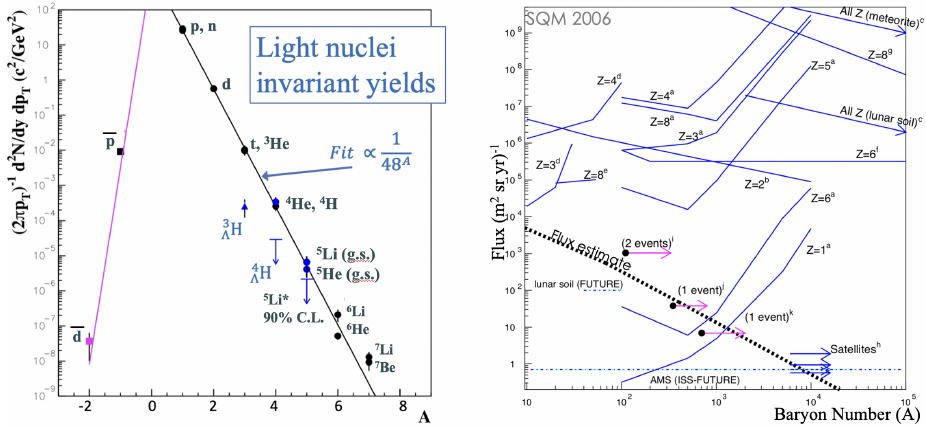
Figure 2. Left panel shows a compilation of some of the banner results from E864: yields and limits for light nuclei, antinuclei, hypernuclei at the AGS, with implications for coalescing strangelets described in text. Right panel gives an overview circa 2006 of searches relevant to strangelets in cosmic rays as strange star relics along with the implied flux. The lunar soil search is long completed [12] and the first published AMS results are recently in [13], to supercede those "future" lines in the figure with sensitivities noted in the